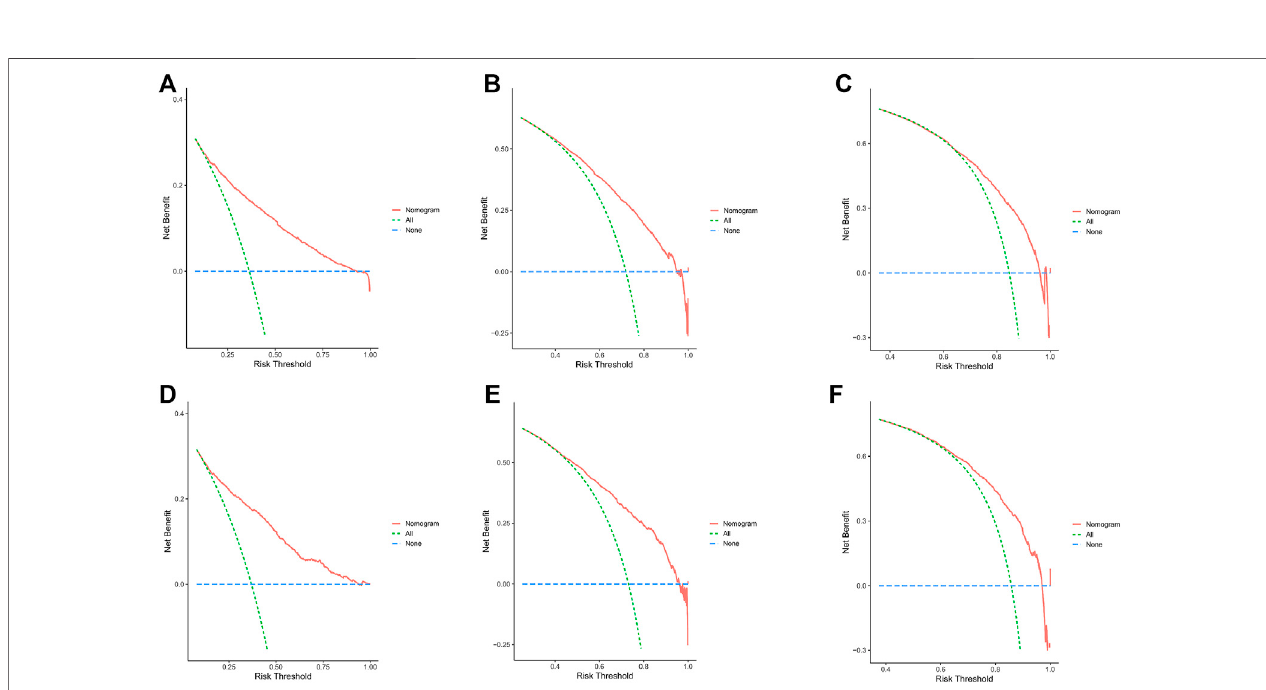
FIGURE 6| (A – C) DCA analysis predicting 1-,3-, and 5-year OS in the training cohort. (D – F) DCA analysispredicting 1-,3-, and 5-year OS in thevalidation